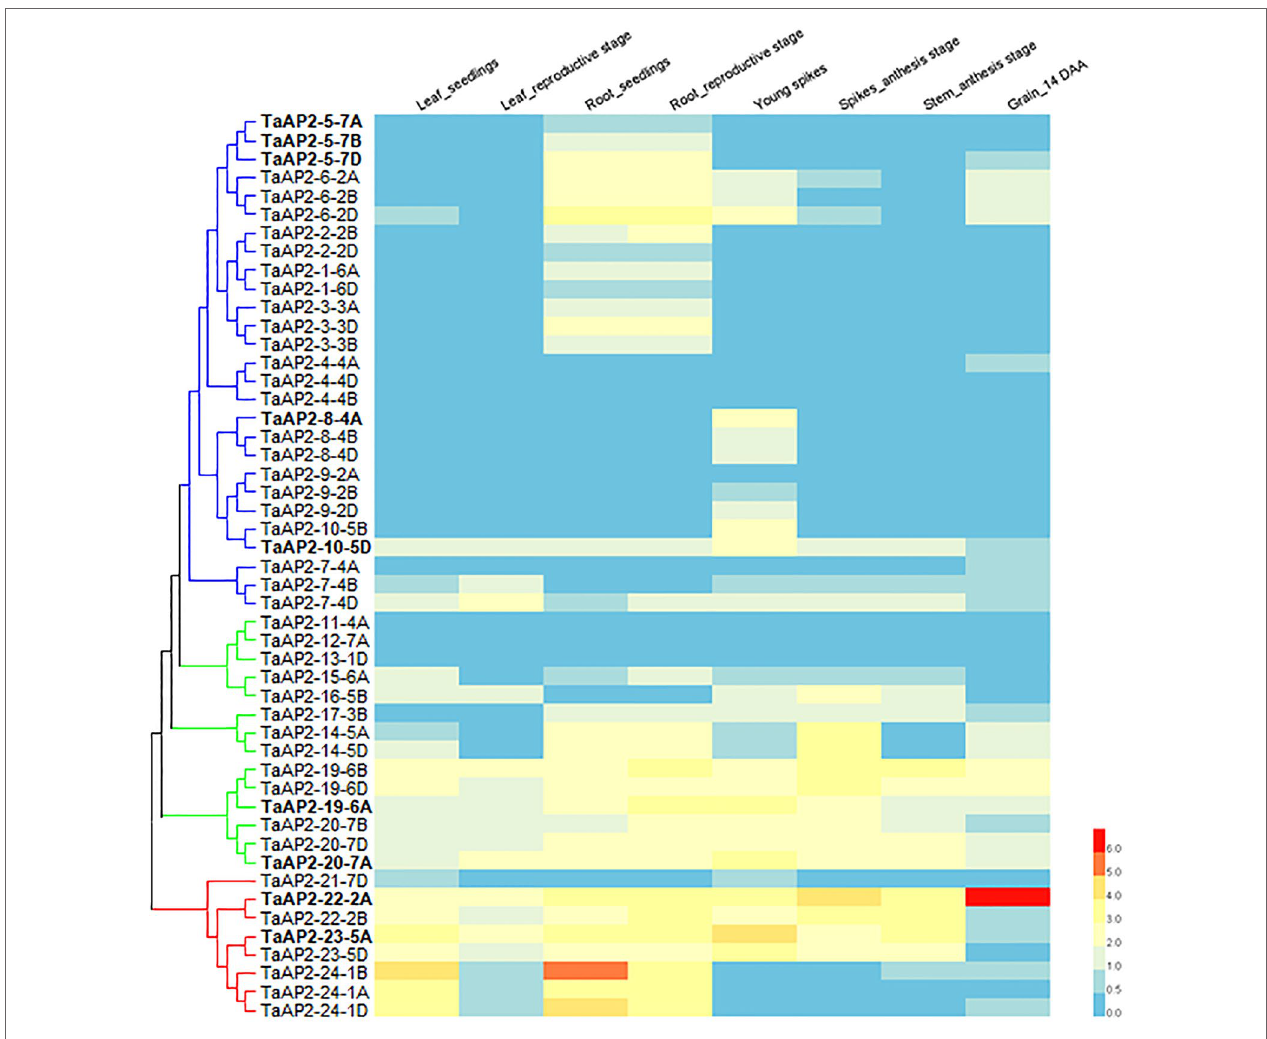
FIGURE 4 | Expression patterns of 49 TaAP2 genes in various tissues at different developmental stages in wheat. The tissues and developmental stages examined are indicated at the top of the heat map. Log 2 transformed (FPKM + 1) expression values were used to create the heat map. The highest level of expression is represented by red (100%), while the low level is represented by blue